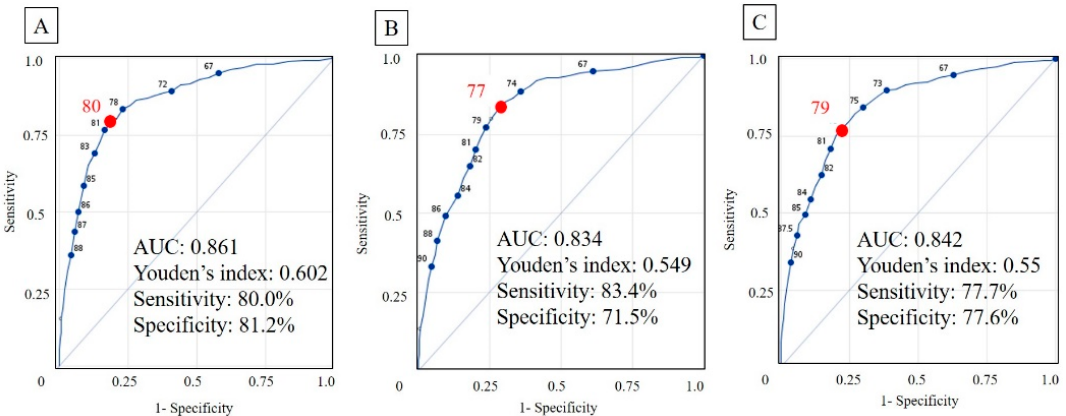
Figure 2. Receiver operating characteristics (ROC) curve of prediction models. The cut-off point was showed as the red dot and number in each ROC curve. ( A ) Model for frailty. ( B ) Model for dementia ( C ) Model for frailty or dementia. AUC, area under the curve.